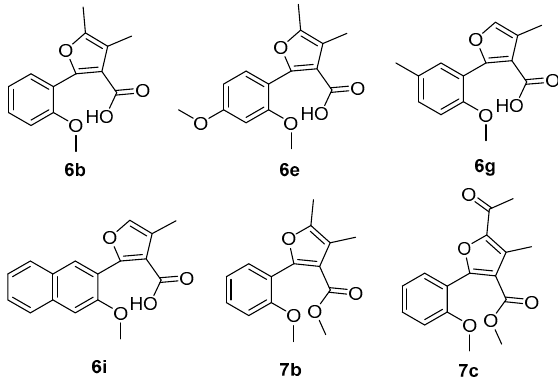
Figure 3. Structures of the most active coumarin ring-opening derivatives.